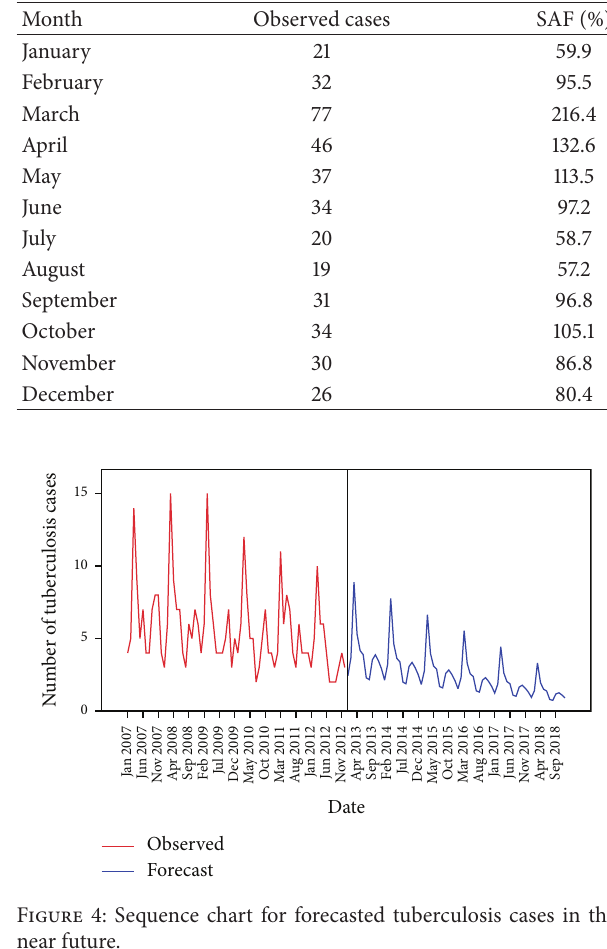
Table 4: Seasonal adjustment factor (SAF) for tuberculosis cases.